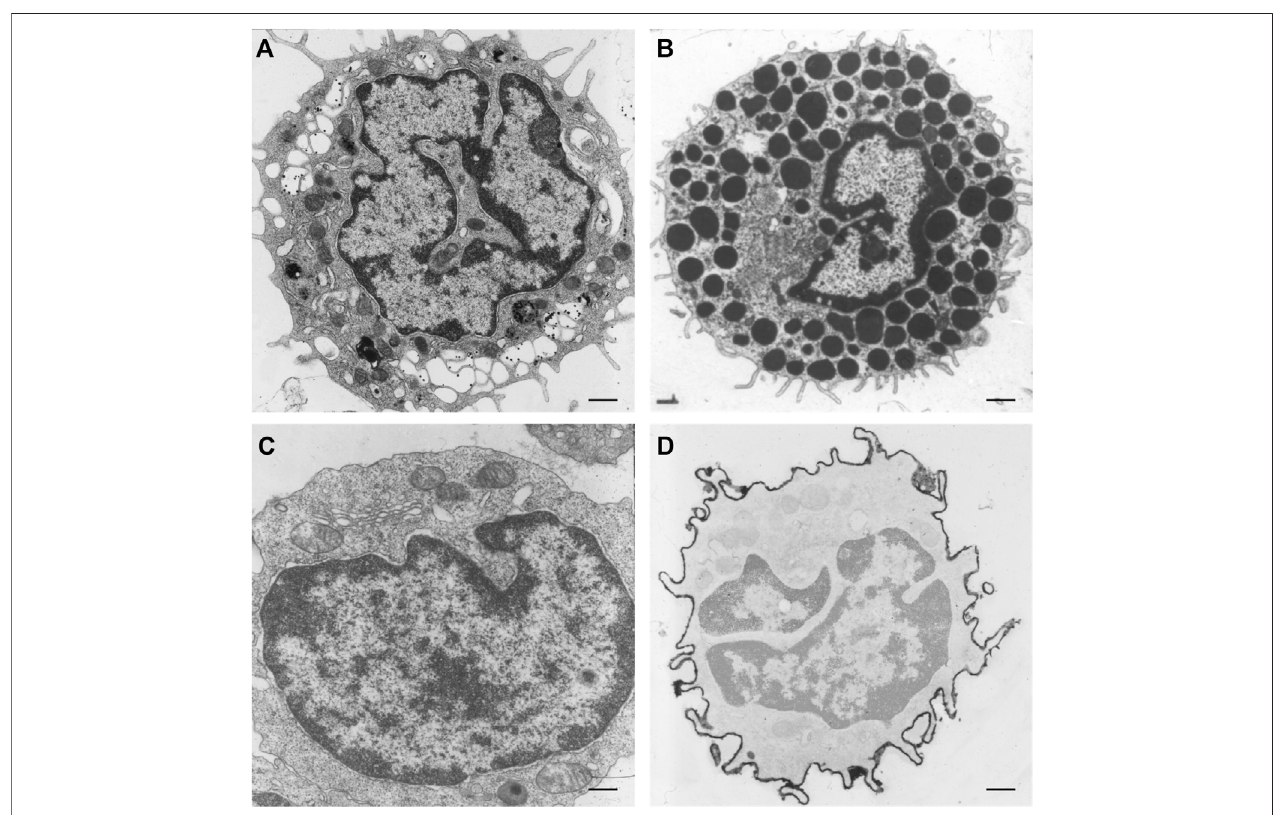
FIGURE 5 | NR invaginations in human hematopoietic cells at the electron microscopy level. (A) Macrophage. (B) Mast cell. (C) T-lymphocyte. (D) B-lymphocyte. Scale bars indicate 1 μ m. Human hematopoietic cells were cultured for at least 48 h in a culture dish after which the medium was discarded. Next, the cells were shortly rinsed with PBS and subsequently fi xed at room temperature with 3% glutaraldehyde in 0.1 M cacodylate buffer (pH 7.4) supplemented with 0.5 mM CaCl 2 for at least 24 h. The cells were then post fi xed with 2% OsO 4 in cacodylate buffer (pH 7.4) containing 1.5% potassium ferricyanide at 48 ° C for 1 h. After a short rinse in cacodylate buffer, the cells were further dehydrated in graded ethanol seriesbefore embedding in epon. Ultra-thin sections were counterstained with uranylacetateand lead citrate prior to examination in a Philips CM 100 electron microscope.